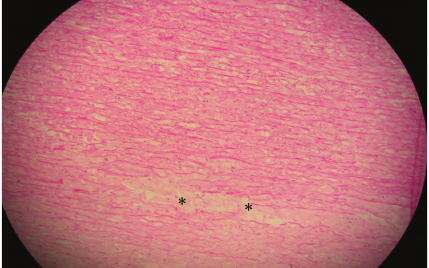
Figure 4: Accumulation of basophilic ground substance ( ∗ ) in cystic media degeneration and